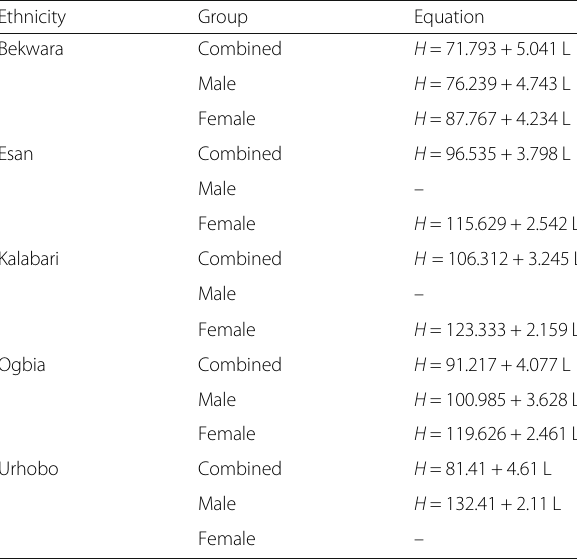
Table 5 Simple regression models for height estimation using